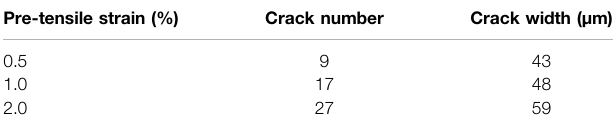
TABLE 4 | Crack parameters of preloaded CR2-0.4